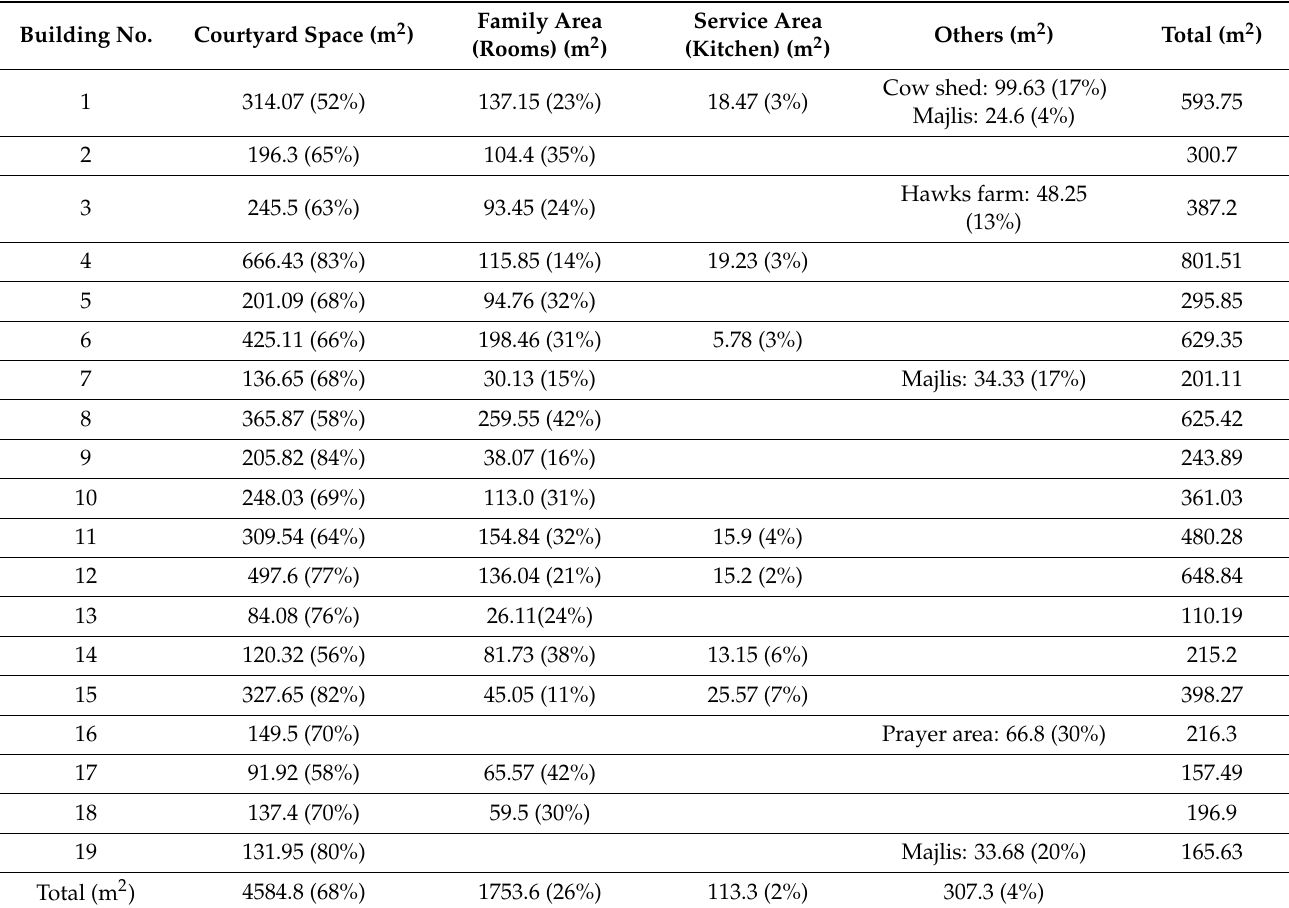
Table 1. Comparative analysis of different functional